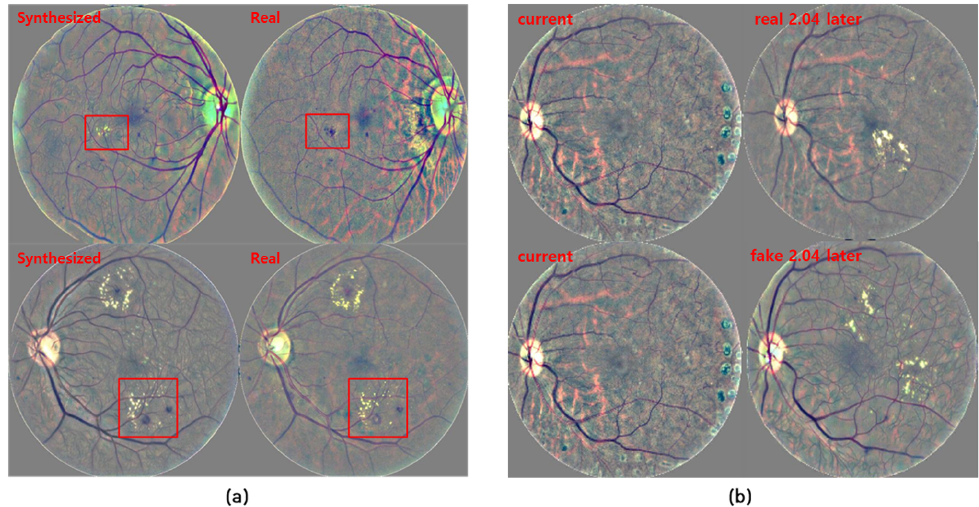
Figure 5. In ( a ), the synthesized lesion is shown by comparing the lesions in the red box, unlike the real lesion, and in ( b ), the future image is synthesized by predicting differently from the progression of the real